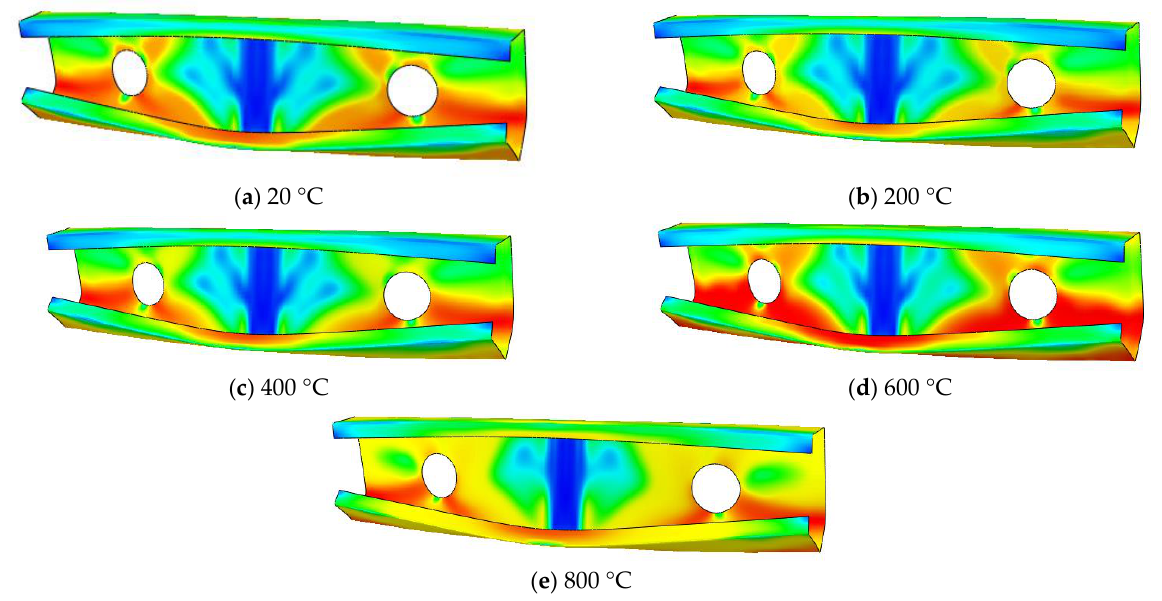
Figure 14. Failure modes of specimen C150-50-20-t2.5-N50-A0.4-FR under different temperatures. Table 6. Average strength reduction percentage (%) of investigated sections at elevated tempera- ture against ambient temperature ( T = 20 ℃ ).